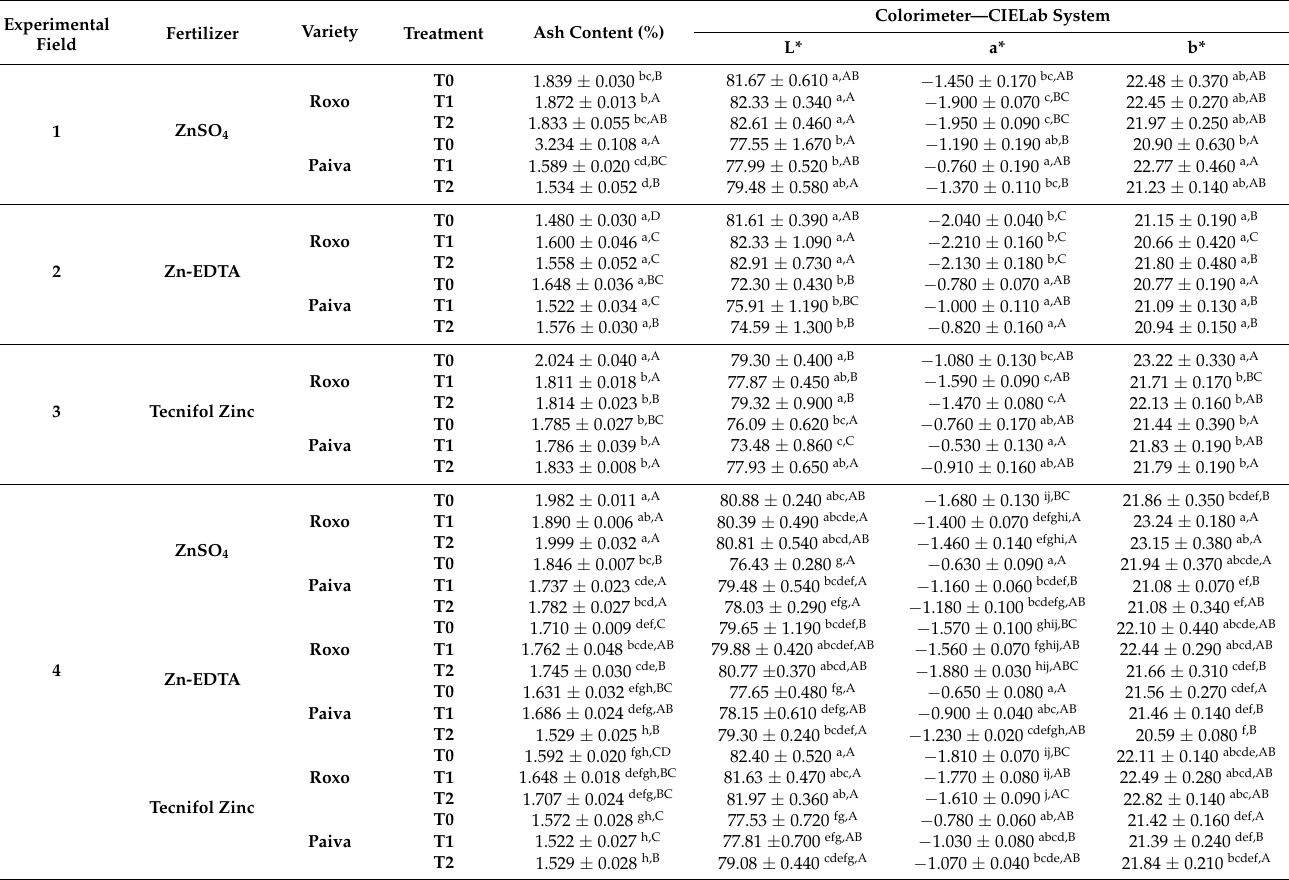
Table 4. Ash Content ( n = 3) and Colorimeter parameters—CIELab System ( n = 12) of whole wheat flour of Triticum aestivum L., varieties Roxo and Paiva, from 1–4 experimental